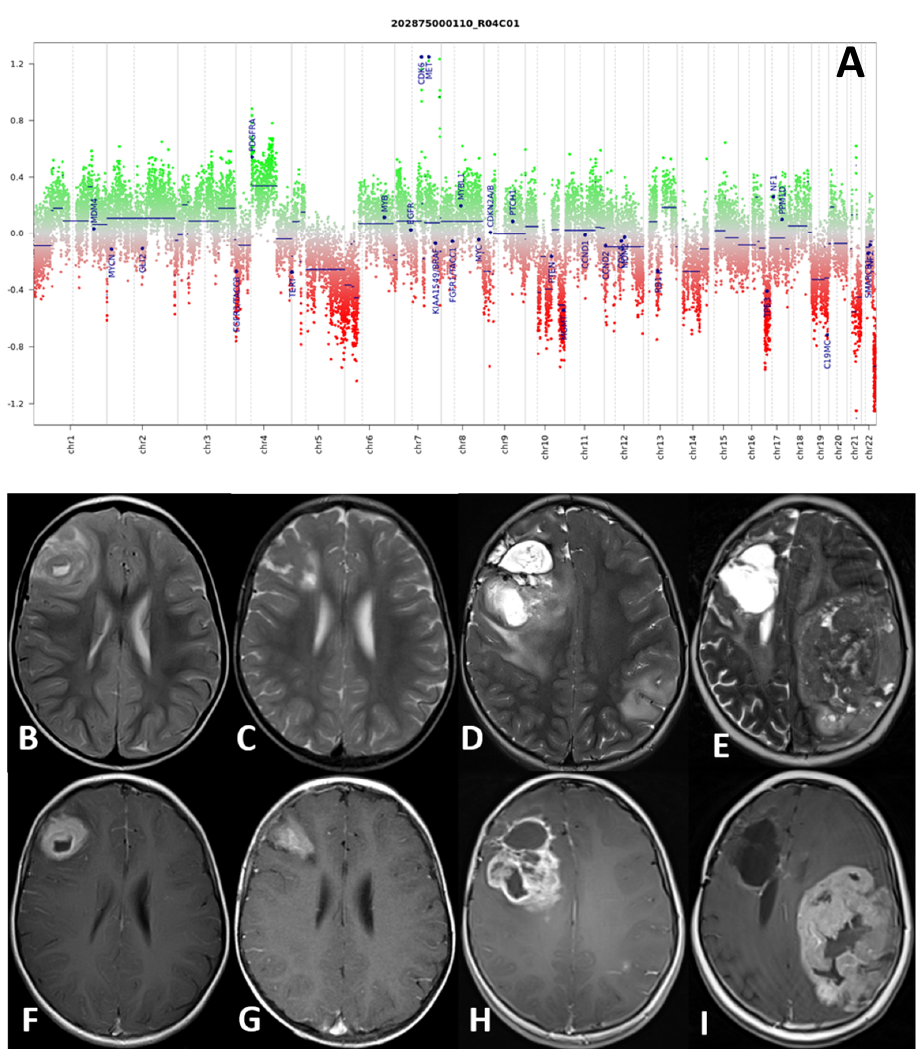
Figure 2. ( A – I ) Molecular profile ( A ) and MRI at four consecutive time-points of patient number 4. DNA methylation profile showed a complex copy number variation (CNV) with CDK6 and MET amplification, and a platelet-derived growth factor A (PDGFRA) gain ( A ). Axial TSE T2-weighted ( upper row ) and post-gadolinium SE T1-weighted ( lower row ) sequences at four consecutive time points: at presentation ( B , F ), at first local recurrence after surgery ( C , G ), at second local recurrence after reoperation ( D , H ), and spreading to the contralateral hemisphere ( E , I ). The right frontal high- grade glioma and recurrences present with a non-homogeneous hyperintense signal on T2-weighted and intense and non-homogenous contrast enhancement on T1-weighted